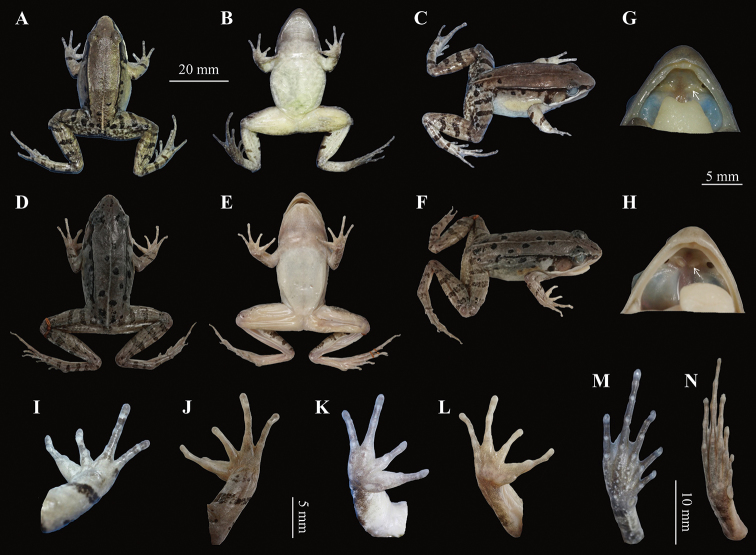
The holotype specimen CIBTZ20190608004 of Nidirana
yeae sp. nov. and topotype specimen CIB2011081603 of N.
daunchina. A–C Dorsal view, ventral view and dorsolateral view of CIBTZ20190608004 D–F dorsal view, ventral view and dorsolateral view of CIB2011081603 G, H oral cavity of CIBTZ20190608004 and CIB2011081603 (arrow point to vomerine ridge) I, J dorsal view of hand of CIBTZ20190608004 and CIB2011081603 K, L ventral view of hand of CIBTZ20190608004 and CIB2011081603 M, N ventral view of foot of CIBTZ20190608004 and CIB2011081603.